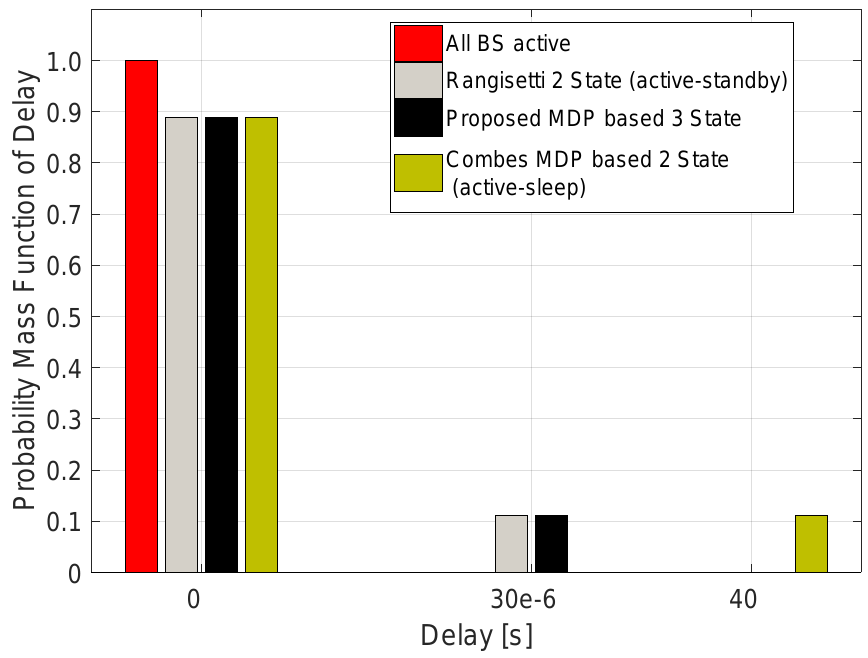
Figure 7. Percentage of users experiencing